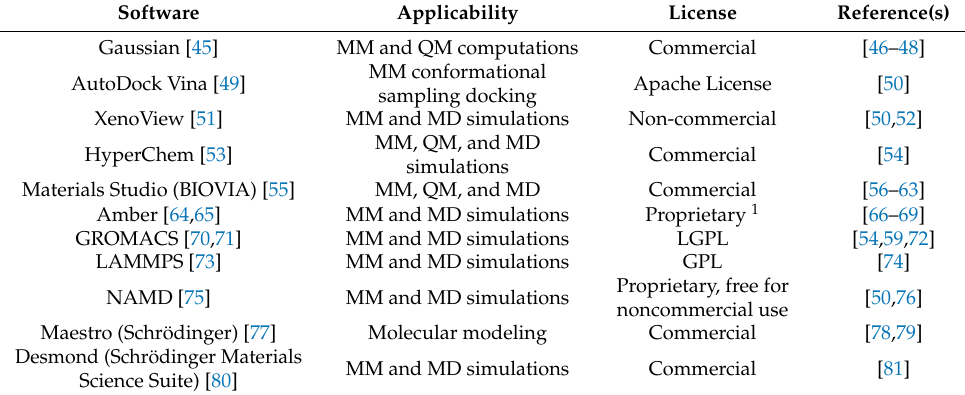
Table 2. Molecular modeling software applied in this review to studying ASD